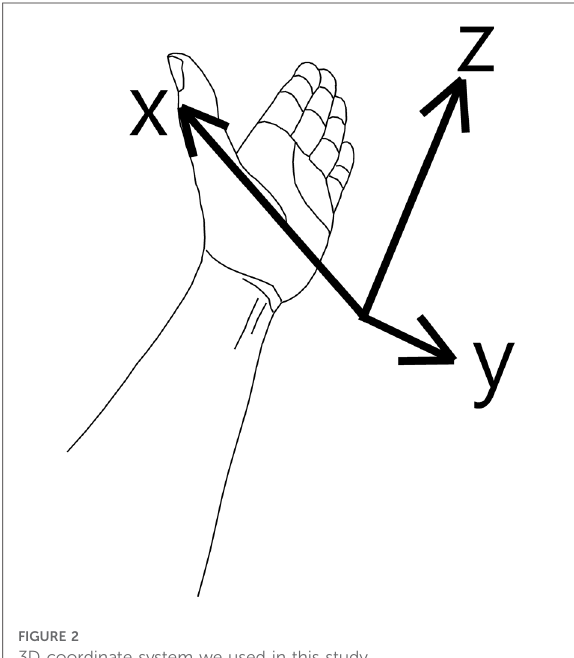
FIGURE 2 3D coordinate system we used in this